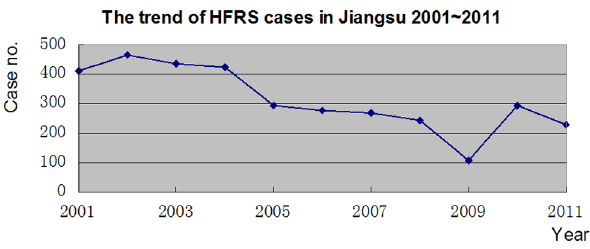
Figure 3. The trend of the number of HFRS cases in Jiangsu from 2001 to 2011. Each point represents the number of HFRS cases in a specific year. All of the points are lined to indicate the trend of the HFRS cases in